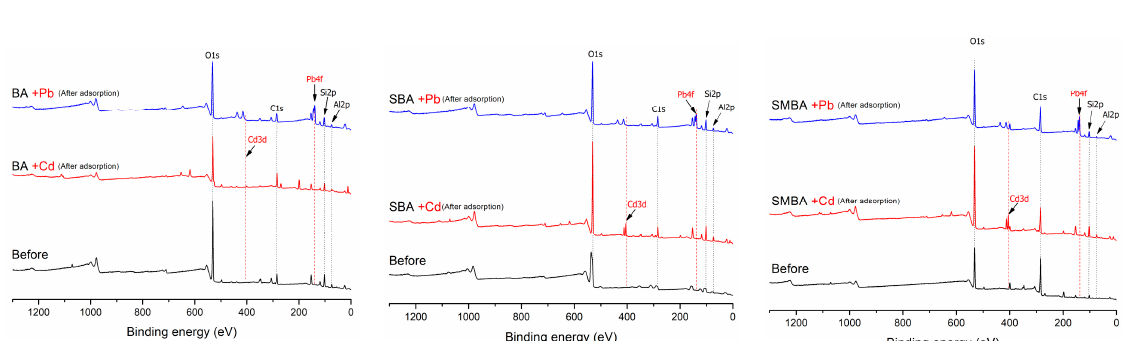
Figure 4. XPS survey spectra for amendments before and after cadmium and lead adsorption.